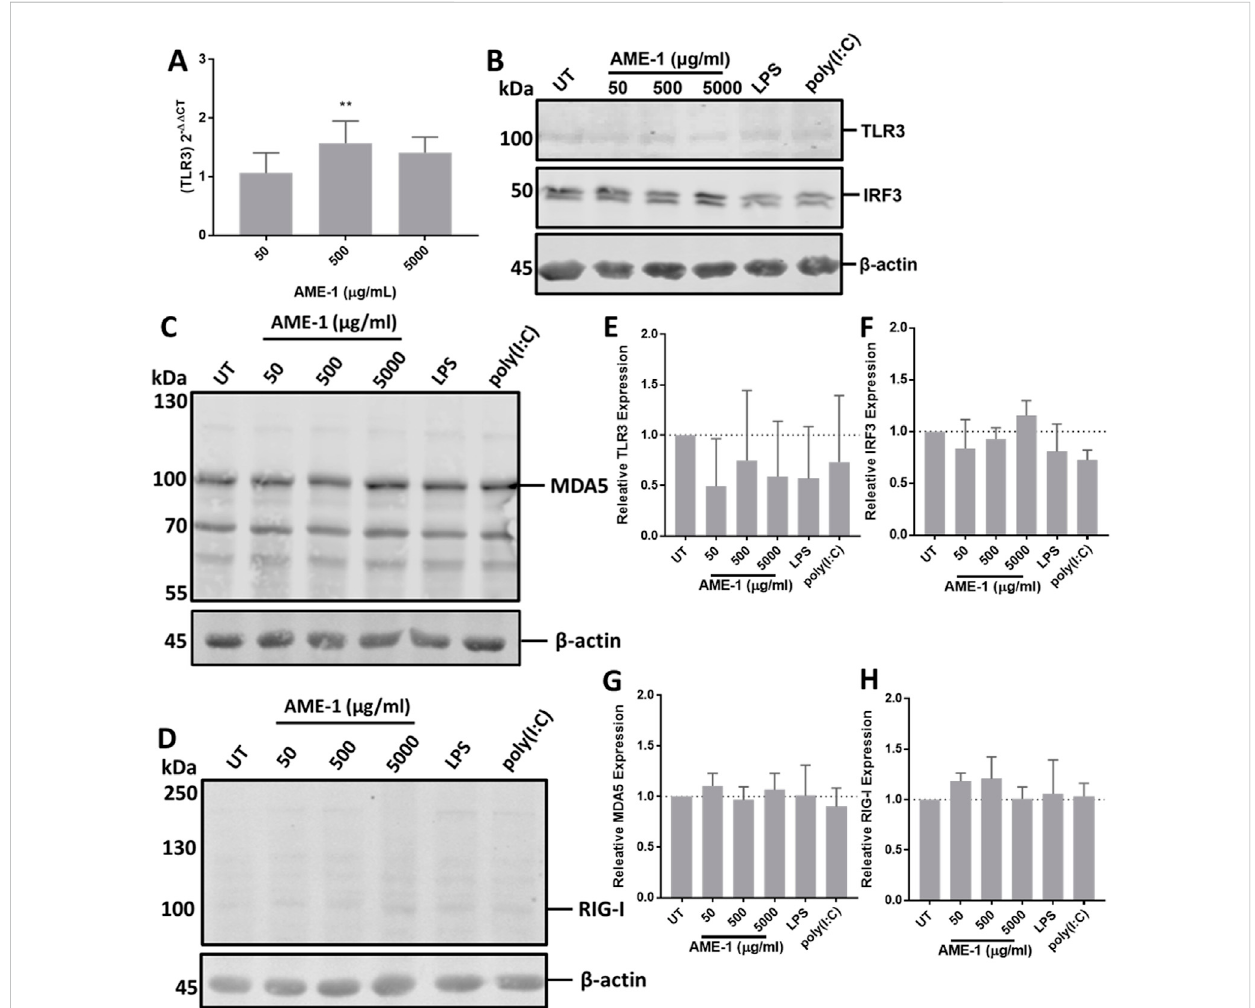
FIGURE 8 AME-1 upregulates TLR3 expression. (A) HMC3 cells were treated with AME-1 (50 – 5,000 μ g/mL) for 3 h, RNA was extracted and analyzed via RT- qPCR. Results are presented as fold-gene expression relative to untreated cells and statistics were calculated using One-Way ANOVA with Dunnett ’ s multiple comparison post hoc analysis relative to fold-change in GAPDH expression: p ≤ 0.01 (**). Data presented as mean ± SEM for n = 3. HMC3 were treated with AME-1 (50 – 5,000 µg/mL), LPS (1 µg/m) or poly(I:C) (0.5 µg/mL) for 24 h, the cells were lysed and analyzed via Western blot. (B) TLR3 and IRF3 protein expression and (E, F) corresponding densitometry analysis. (C, D) MDA5 and RIG-I protein expression and (G, H) corresponding densitometry analysis. Densitometry analysis was performed on three blots on the indicated bands and statistical signi fi cance was calculated using one- way ANOVA with Tukey post hoc